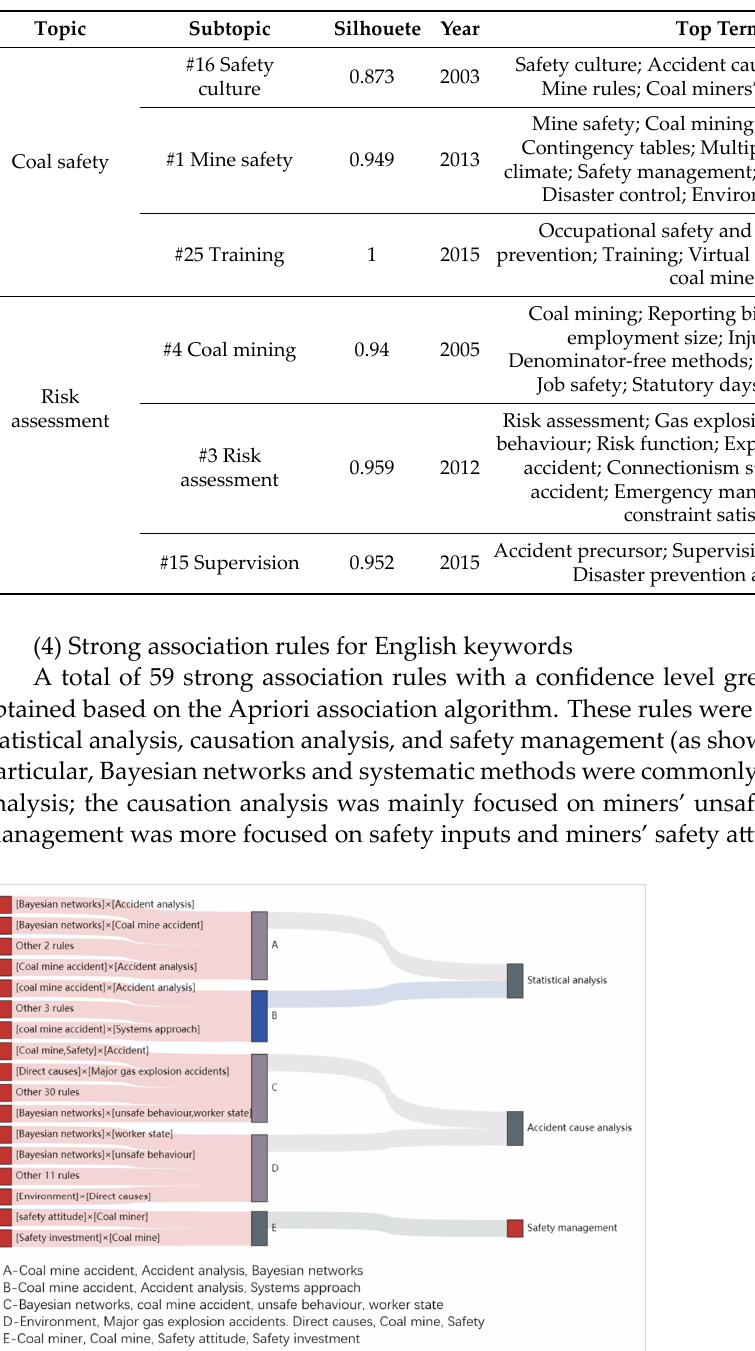
Table 6. Topic and top term of Safety Management.